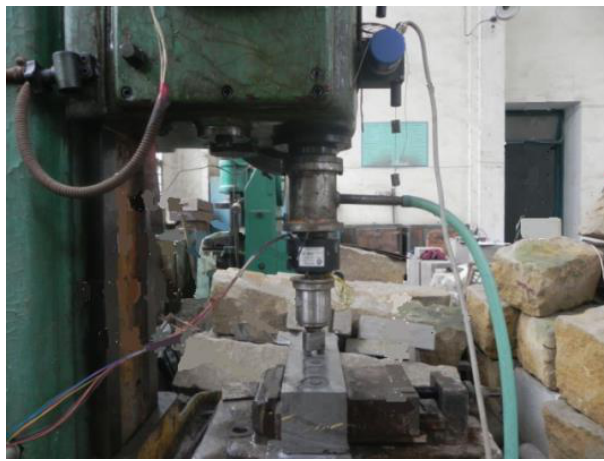
Figure 5. The process of impregnated tooth cutting